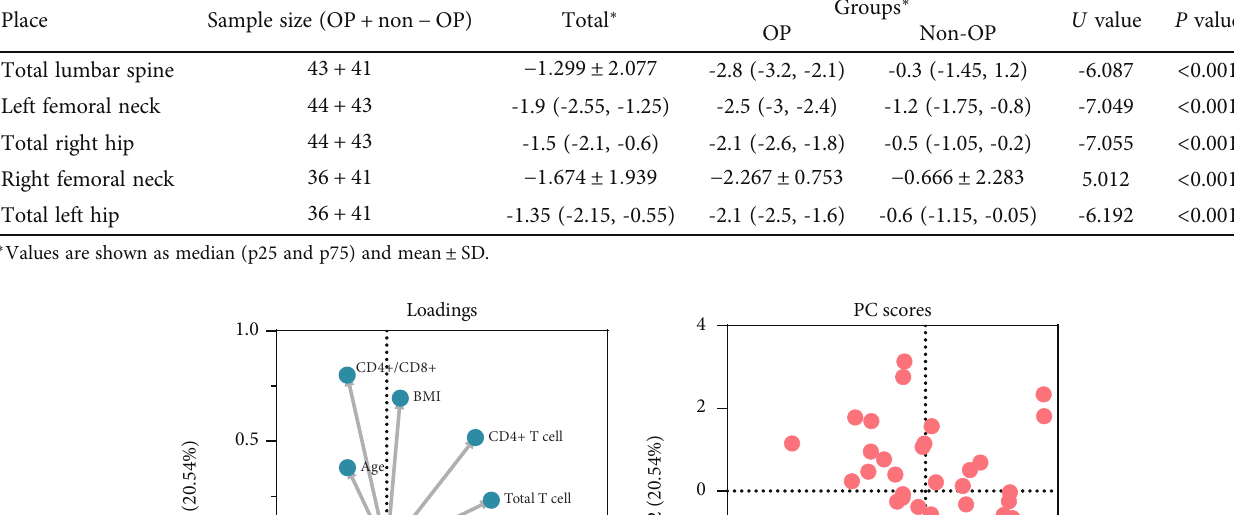
Table 2: Comparison of BMD values at di ff erent bone sites between OP and non-OP groups. Place Sample size ( OP + non − OP ) Total ∗